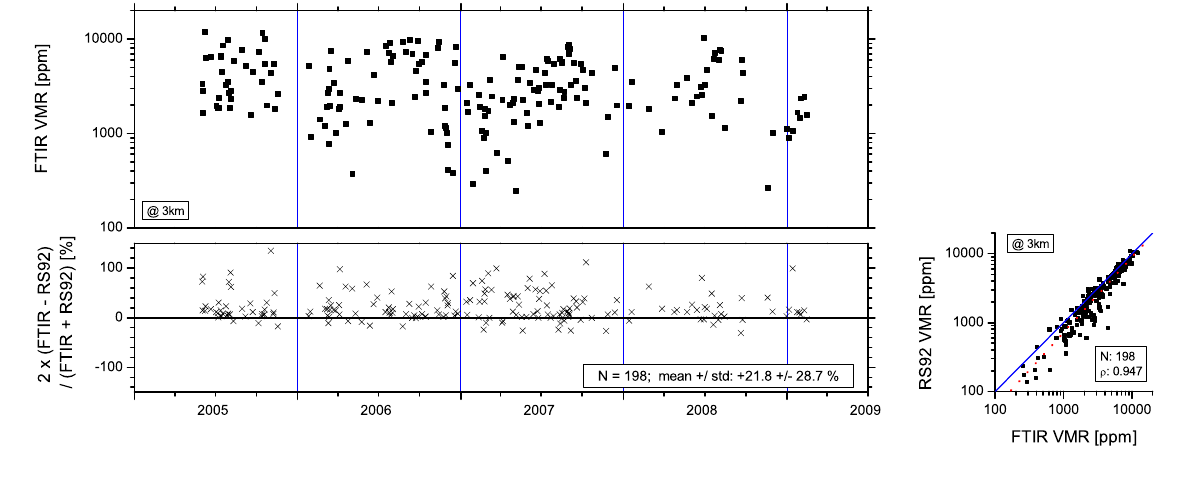
Fig. 9. Comparison of RS92 and FTIR lower tropospheric (altitude of 3km) water vapour mixing ratios, whereby the RS92 mixing ratios have been smoothed according to Eq. (2). Left panels: time series for FTIR/RS92 coincidences, top panel: FTIR mixing ratios, bottom panel: × ( FTIR − RS92 ) difference between FTIR and RS92 ( 2 ); Right panel: correlation plot for all coincident measurements between 2005 and 2009. ( FTIR + RS92 )